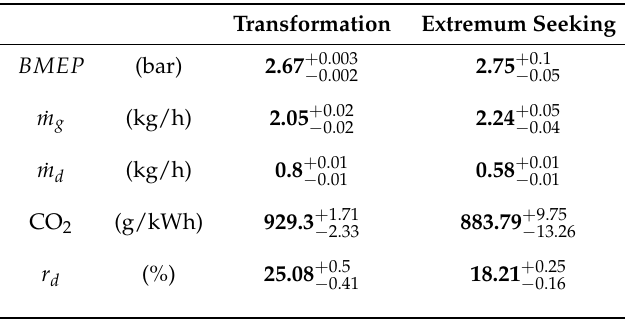
Table 5. Consumption comparison at alternative operating point. The subscripts and superscripts show the intervals of the